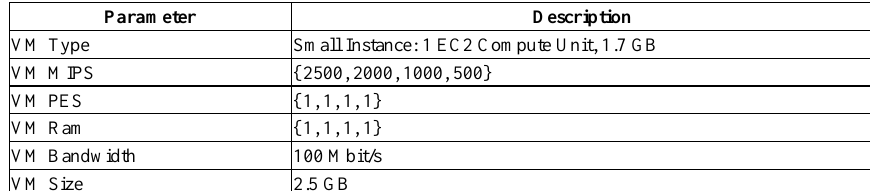
Table 5. VM Specifications